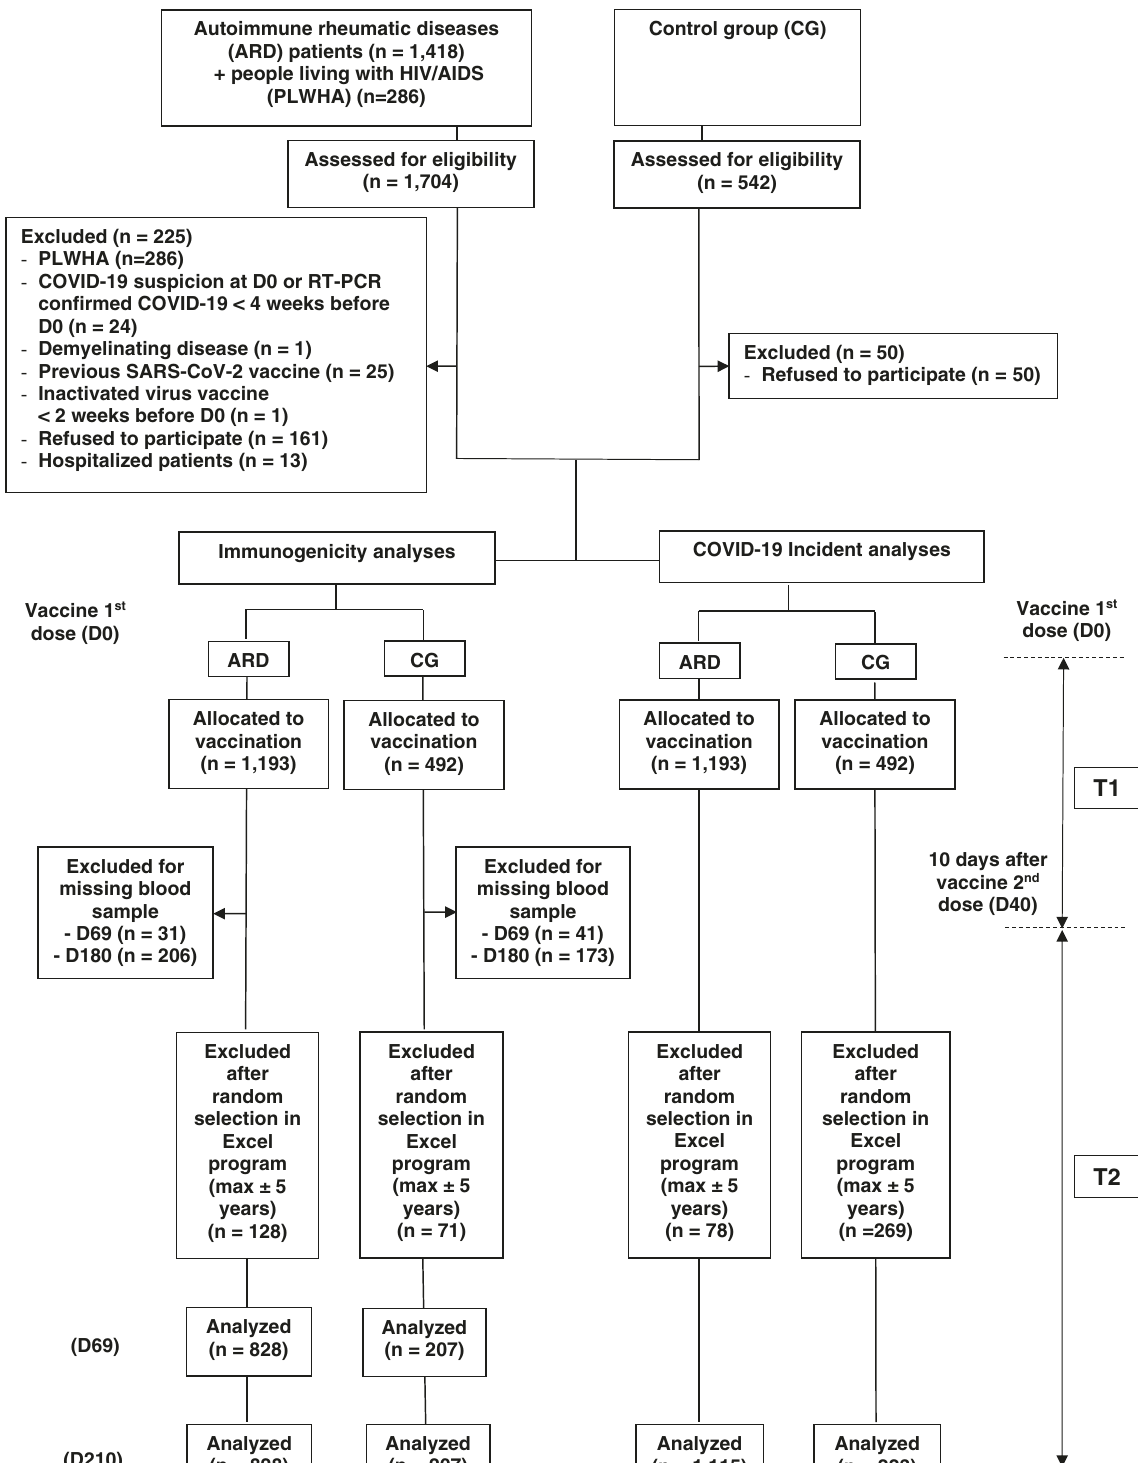
Fig. 1 | Study fl owchart. The fi gure depicts enrollment, exclusions, and ana- lysis of Anti-SARS-CoV-2 antibodies decay and COVID-19 incidence in patients with autoimmune rheumatic disease (ARD) and controls (CG). The partici- pants allocated to vaccination were followed from the day of inclusion, which is the day of fi rst dose vaccination with CoronaVac vaccine (DO) up to 10 days after the second dose vaccination (T1). The second period of follow-